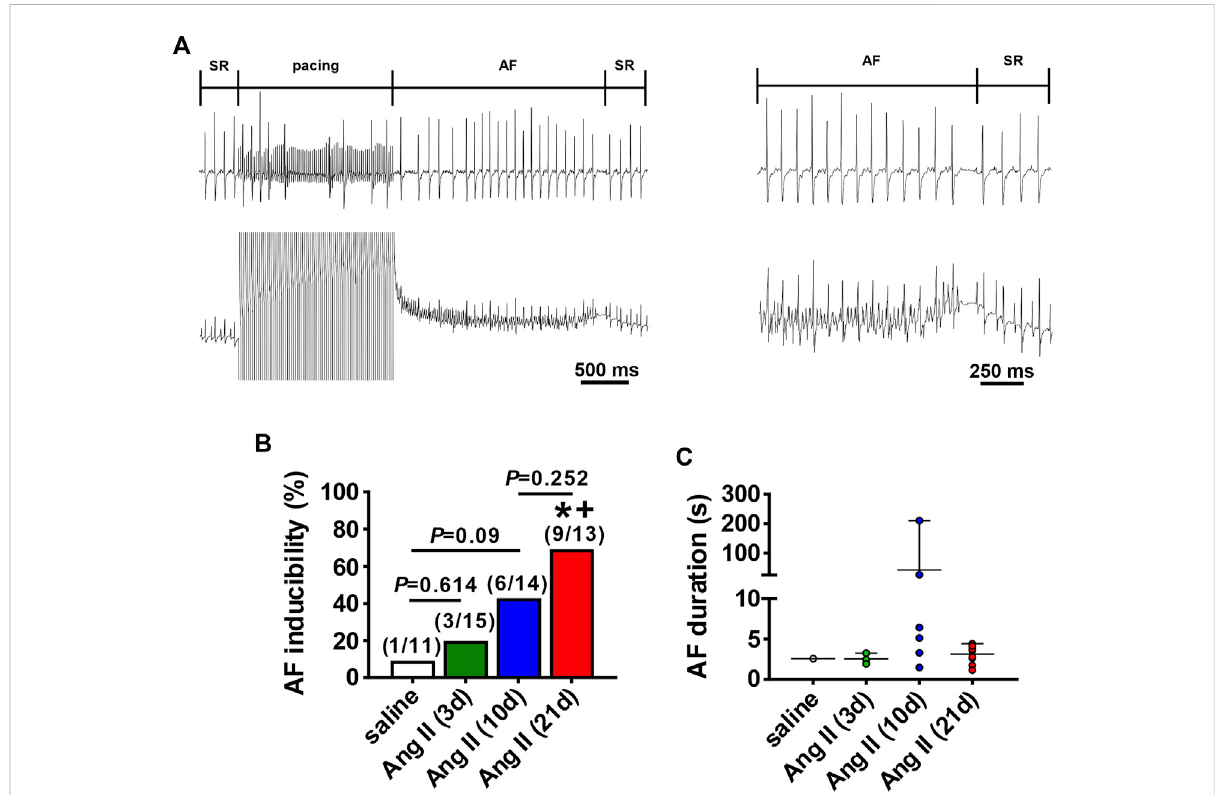
FIGURE 2 Susceptibilitytoatrial fi brillationafterAngIIinfusion. (A) Representativesurface(top)andintracardiac(bottom)ECGsillustratingtheinductionof AFafterburstpacing intherightatriuminamouseinfusedwithAngII.Therecordingsontherightaremagni fi edregionsoftherecordingsontheleft showing the ECGs during AF and the spontaneous reversion back to sinus rhythm (SR). (B) Inducibility of AF in mice infused with saline for 21 days or AngIIfor3,10and21 days.NumbersinparenthesesindicatethenumberofmiceinducedintoAF.* p < 0.05vssaline; + p < 0.05vsAngII(3 days) by Fisher ’ s exact test. (C) Duration of AF in the mice that were induced into AF as shown in panel